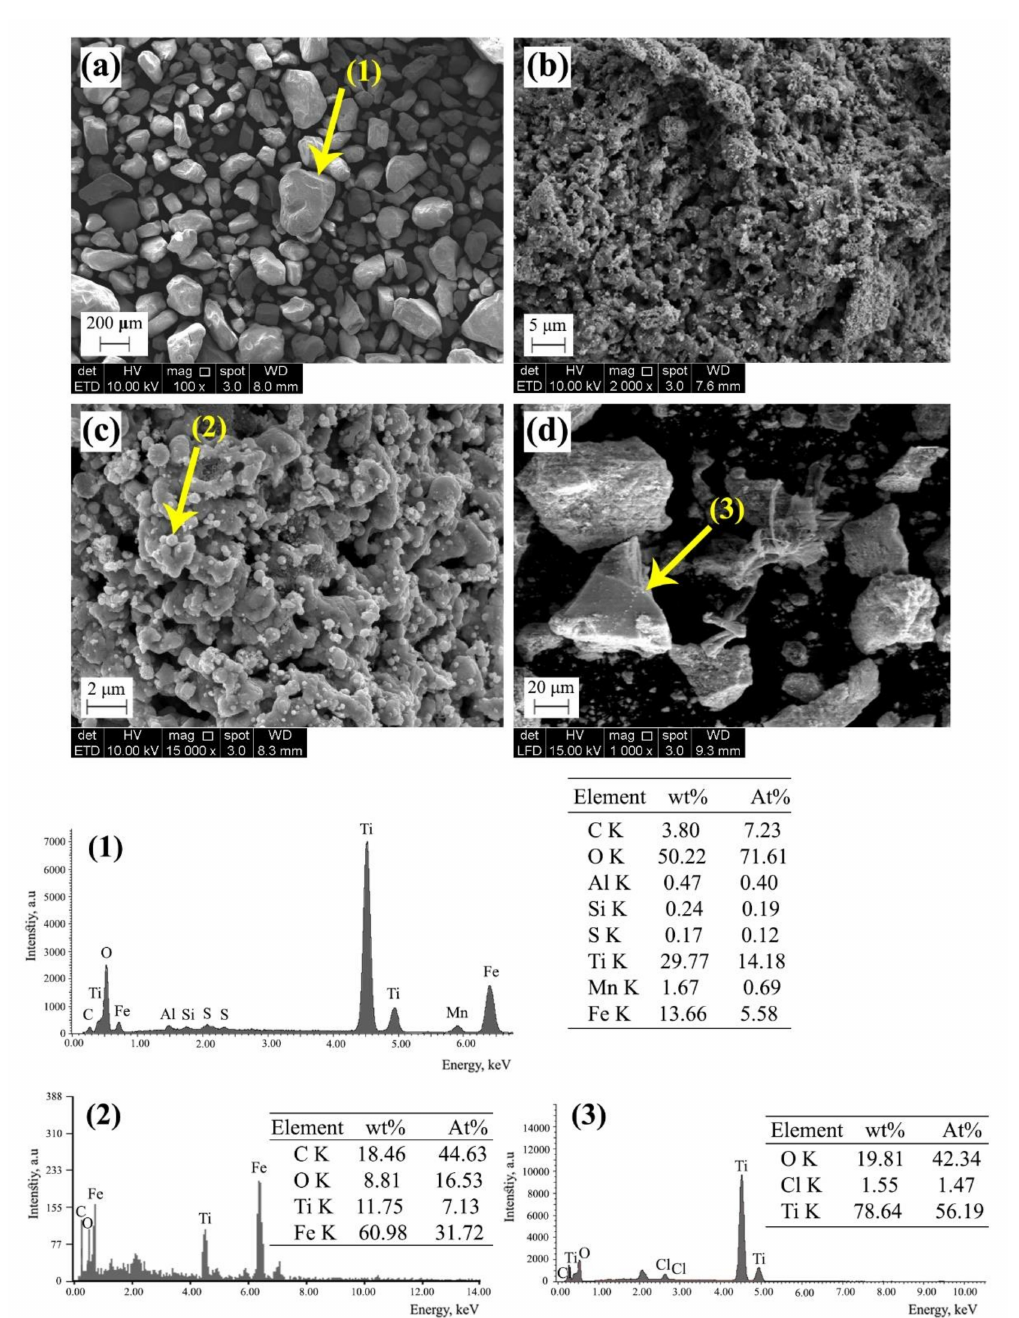
Figure 8. SEM images for: ( a ) as-received ilmenite, ( b ) reduced ilmenite under H 2 -N 2 atmosphere, ( c ) reduced ilmenite after leaching process with spherical Fe particles, and ( d ) TiH 2 powder after water washing and acid leaching. (Point ( 1 ) is EDX analysis micrograph for raw ilmenite, point ( 2 ) is EDX analysis micrograph for spherical particles in reduced ilmenite, and point ( 3 ) is EDX micrograph for obtained TiH 2 powder after water washing and acid